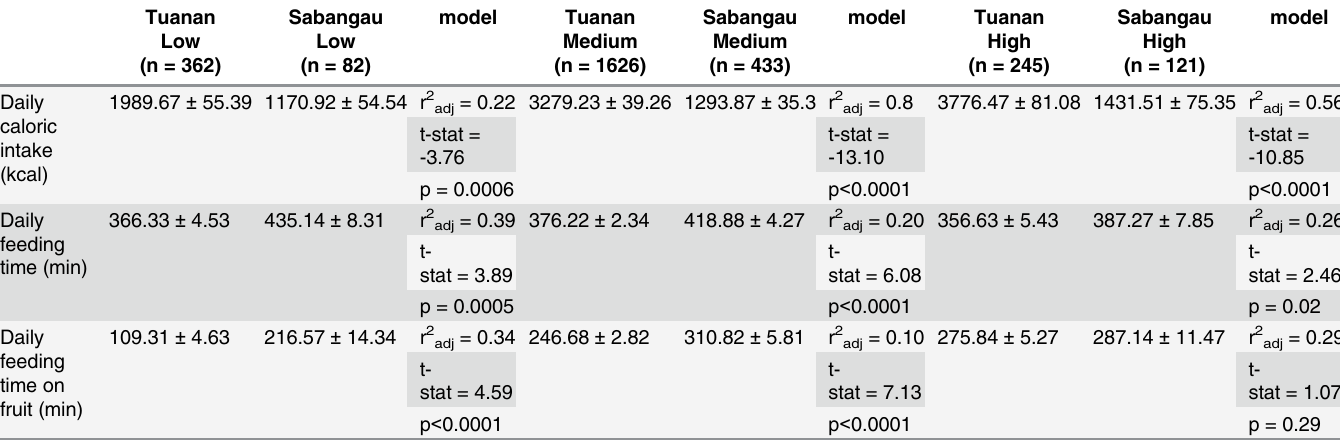
Table 4. Variation in daily energy intake (Kcal), daily feeding time (minute), and daily fruit feeding time (minutes) during low, medium, and high fruit periods. GMM were used to compare the two sites and included orangutan ID as a random effect. Data represent mean ± SE.